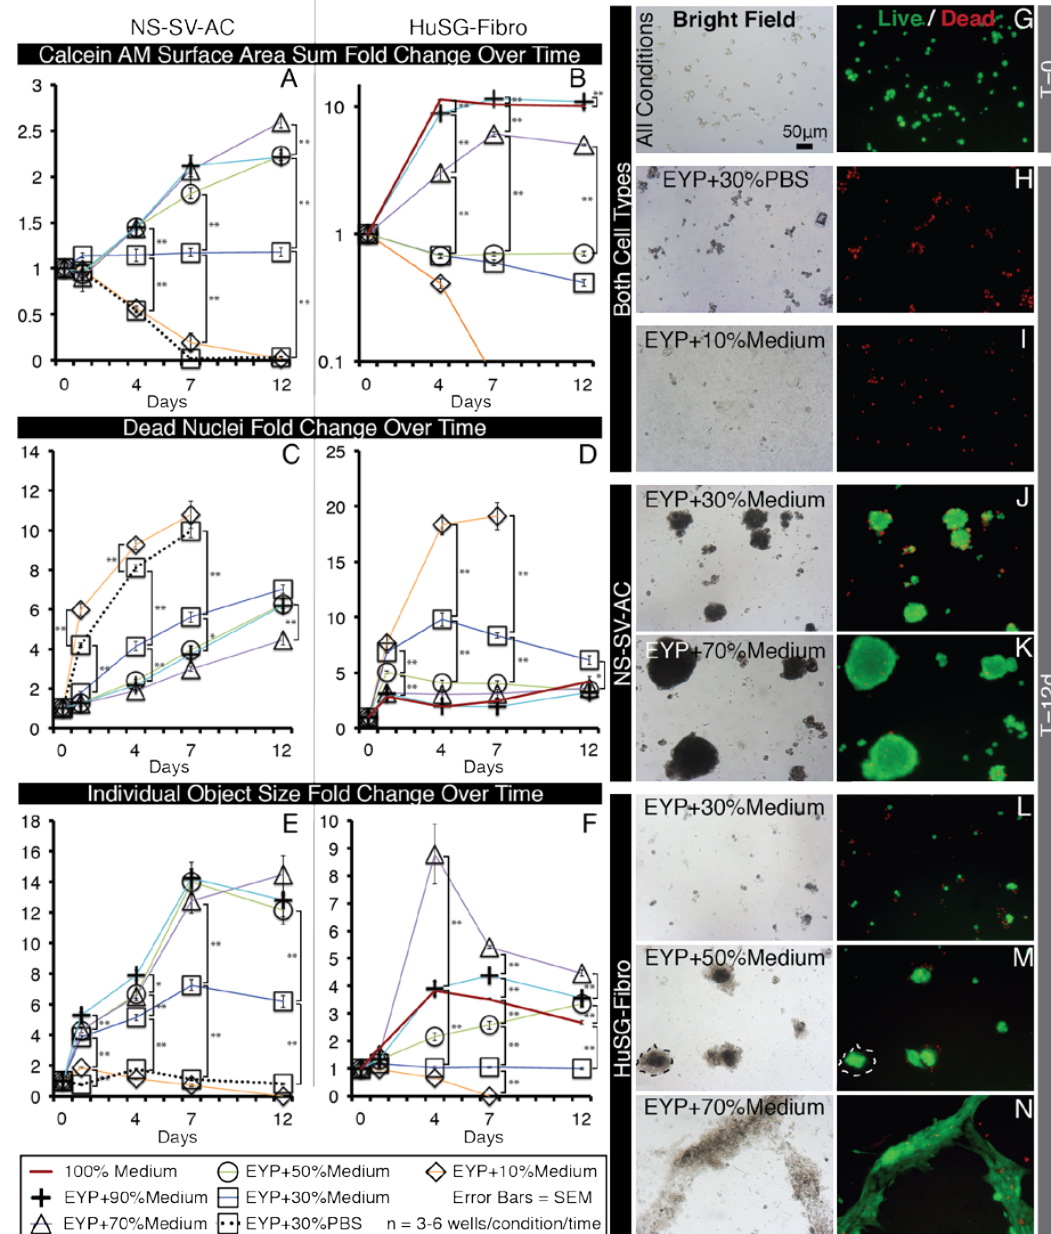
Figure 2. Selected Bright Field and Fluorescent Images of NS-SV-AC and HuSG-Fibro Cells in EYP Cultures with Different Concentrations of Medium, Stained with Live/Dead and Images Quantified by Image Analysis. ( A – F ) Whole well images from 96 well plates were captured with 2X objective and subjected to computer analysis algorithms to detect Calcein AM (live) areas (in µ m 2 ) and EthD (dead) nuclei counts then normalized to T = 0. ( A , B ) In sums, green pixels were added in each well. ( C , D ) For dead cells, individual dead nuclei were counted in each well. ( E , F ) With objects, pixel values for either individual cells or clusters of cells were considered an object and means of their area were calculated per well. For statistical analysis we used one-way ANOVA followed by Tukey’s Post-Hoc test with p -values = * < 0.05, ** < 0.01. ( G – N ) Images captured with 10X objectives from inside wells or a 96 well plate shown representative morphology of Live Dead stained NS-SV-AC or HuSG-Fibro cells in various conditions. Dotted line ( M ) indicates HuSG-Fibro suspected produced substance. More images are found in Figure